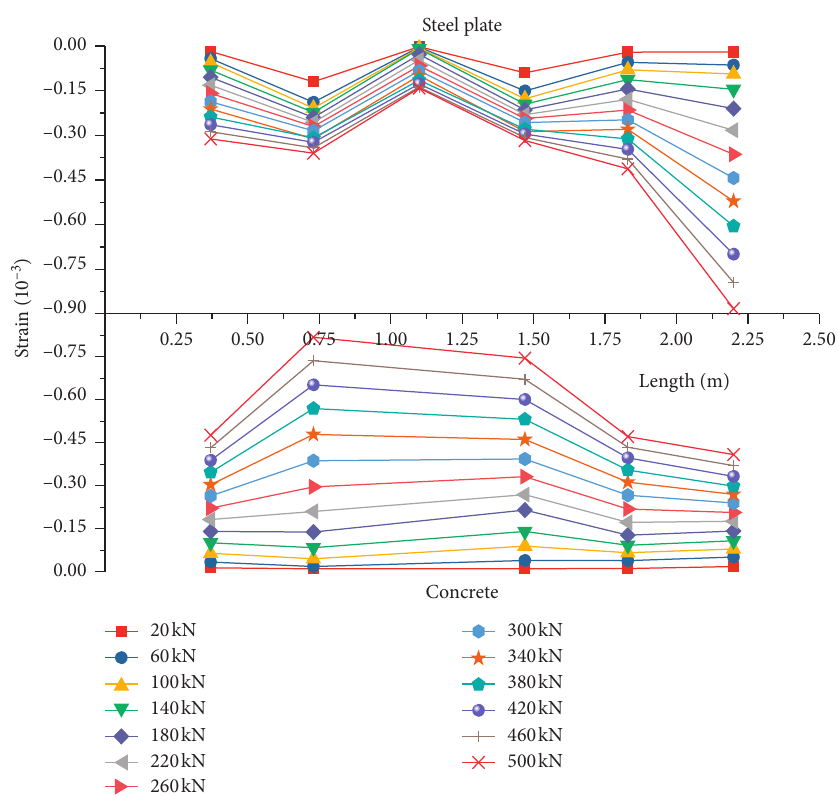
Figure 30: Average strain distribution of jointed specimens in compressive